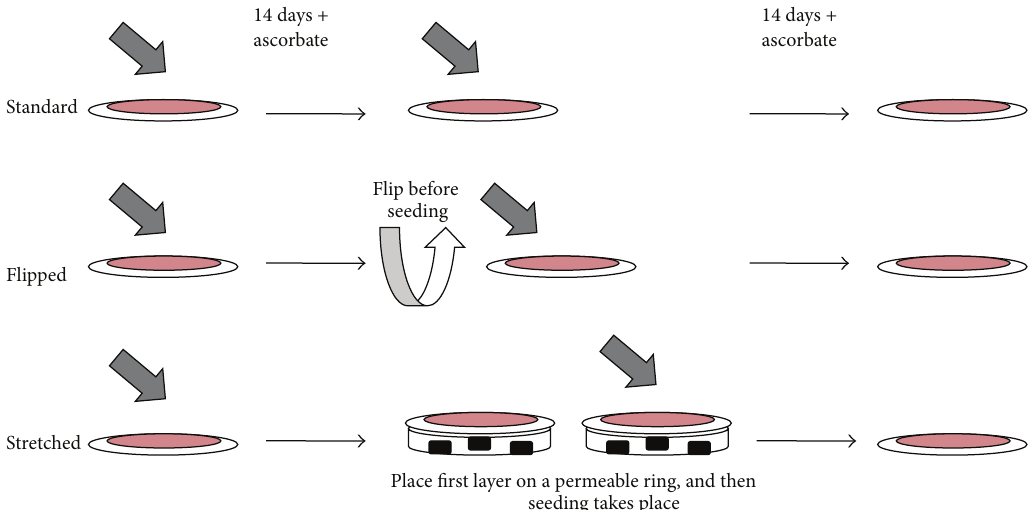
Figure 1: Experimental design of the cell culture part of the study. Fibroblasts were seeded as a confluent layer and cultivated with ascorbate for 14 days. A reseeding of fibroblasts took place: without modification for standard condition, with a flip of the matrix sheet before the seeding for the “flipped” condition, and with the elevation of the matrix sheet on a permeable ring of plastic for the “stretched” condition. All the cultures were pursued for 14 days.